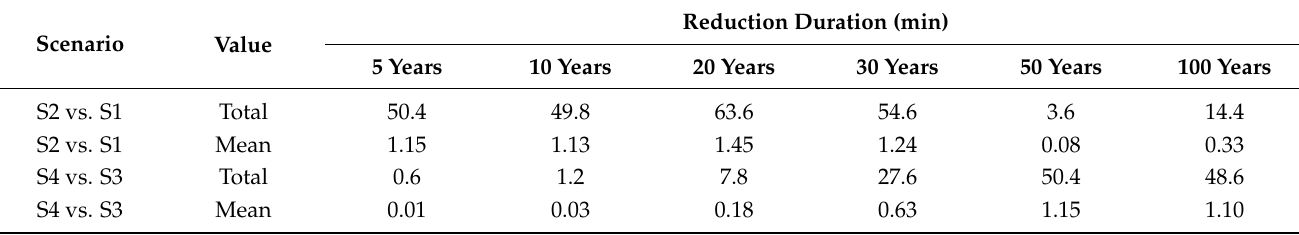
Table 10. Reduction in flooding duration of junction nodes for the discharge route scenarios (S2